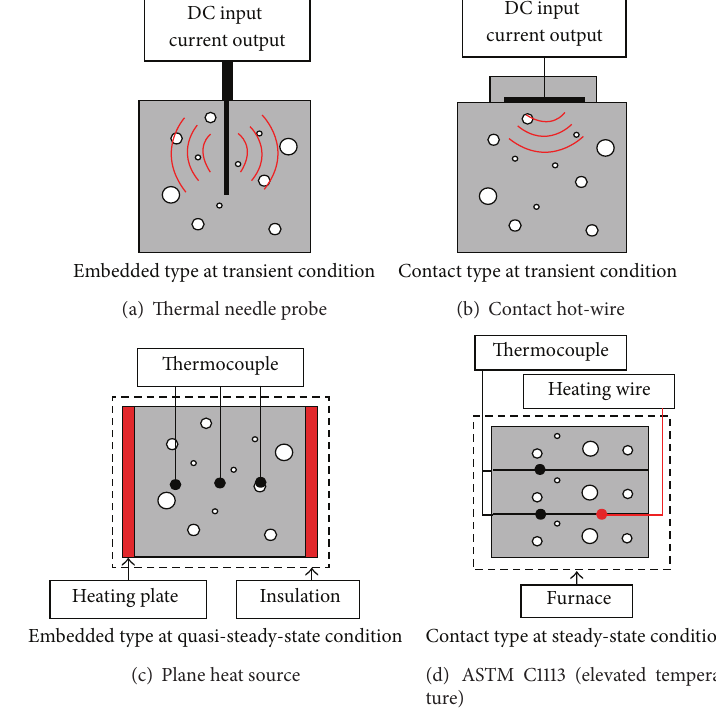
Figure 2: Methods for measuring thermal